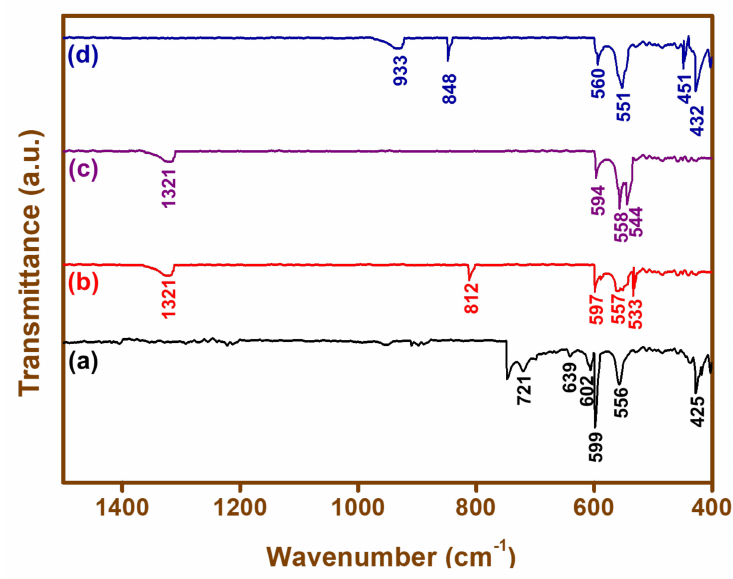
Figure 3. FTIR spectra of ( a ) BFO-C, ( b ) BFO-S, ( c ) BFO-L, and ( d ) BFO-M